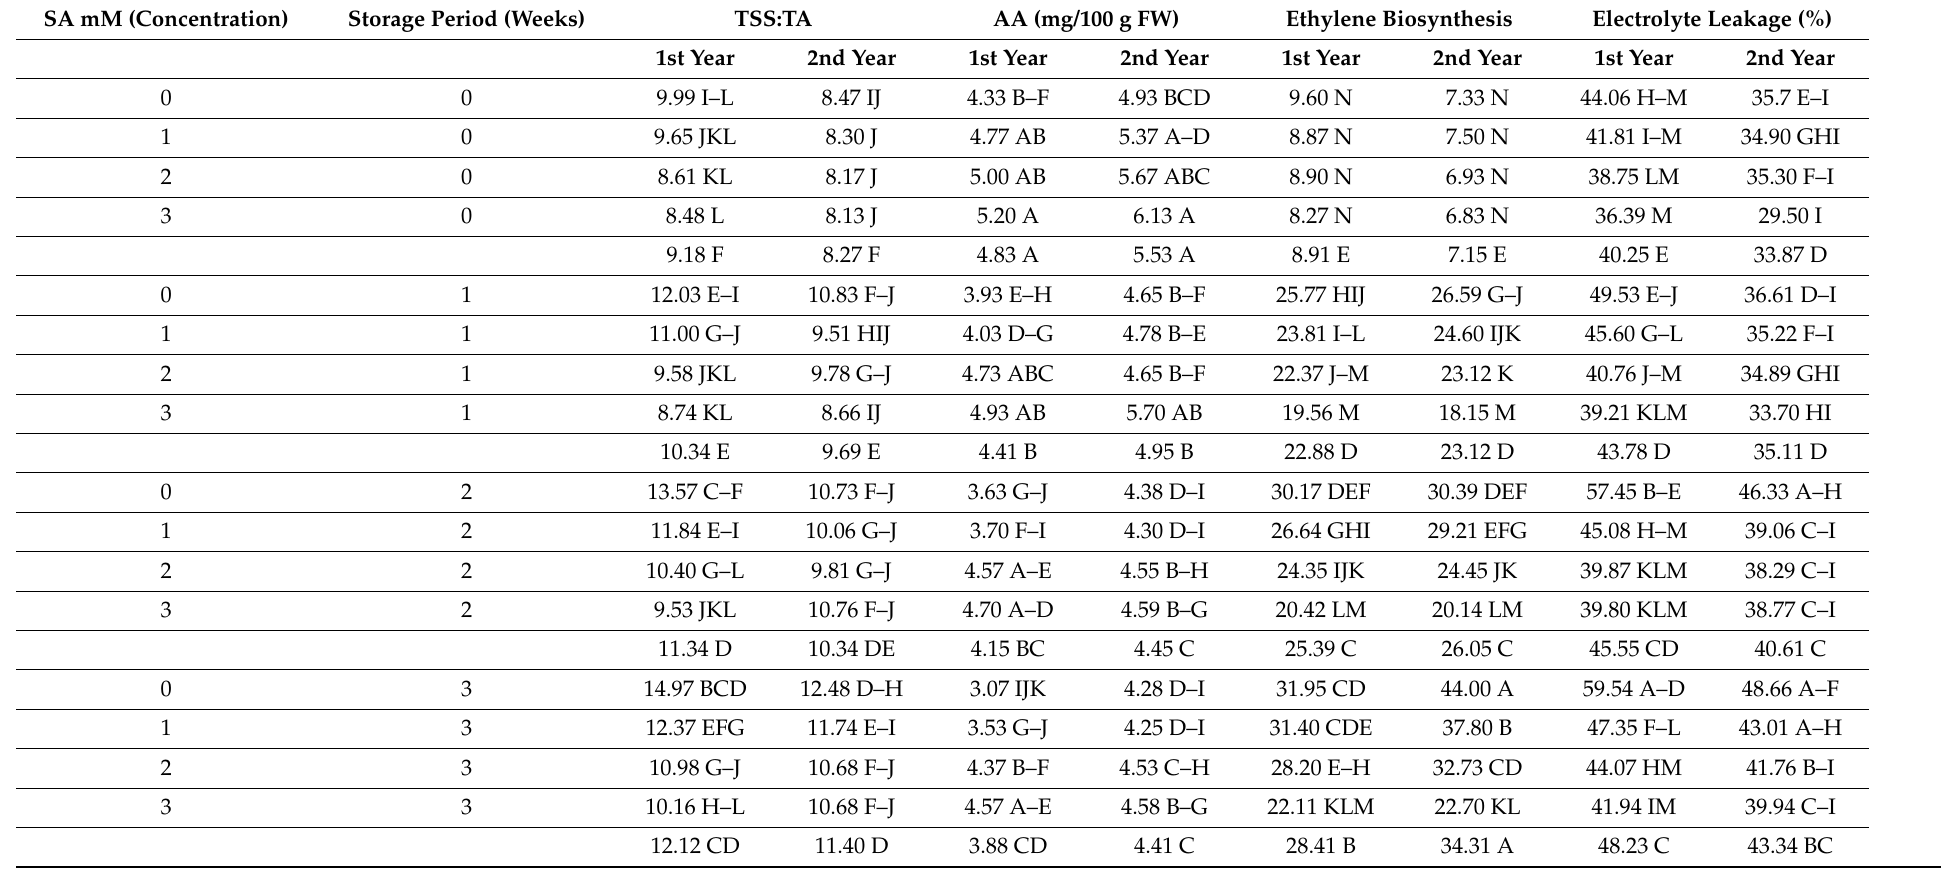
Table 5. Effects of different pre-harvest treatments of SA on the peach fruit physicochemical characteristics during low-temperature storage. SA mM